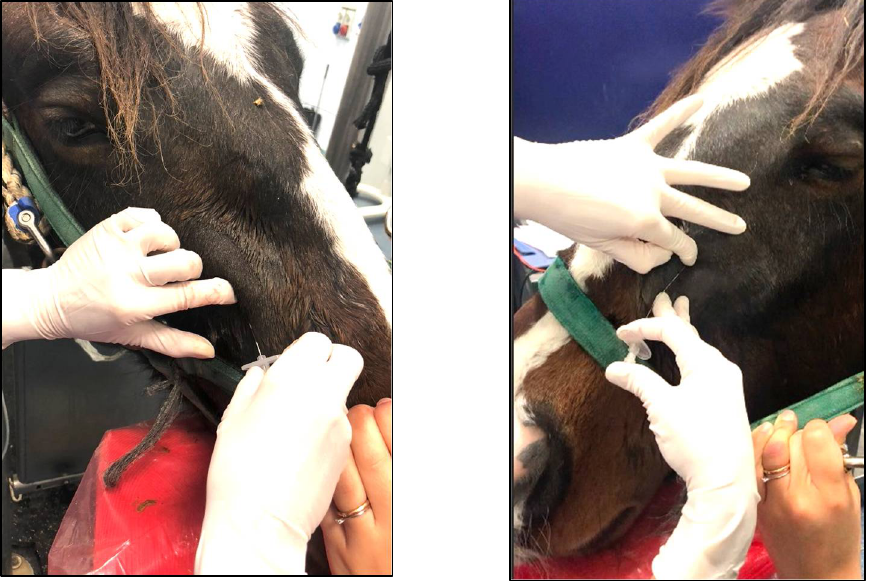
Figure 4. December 2019: a 3-year old horse in group STA undergoing bilateral rhinoplasty and nasal septum reconstruction. Particular of the insertion of a 20 G × 9 cm Tuohy needle into each infraorbital canal while elevating the infraorbital nerve and the levator labii superioris muscle with the index finger.